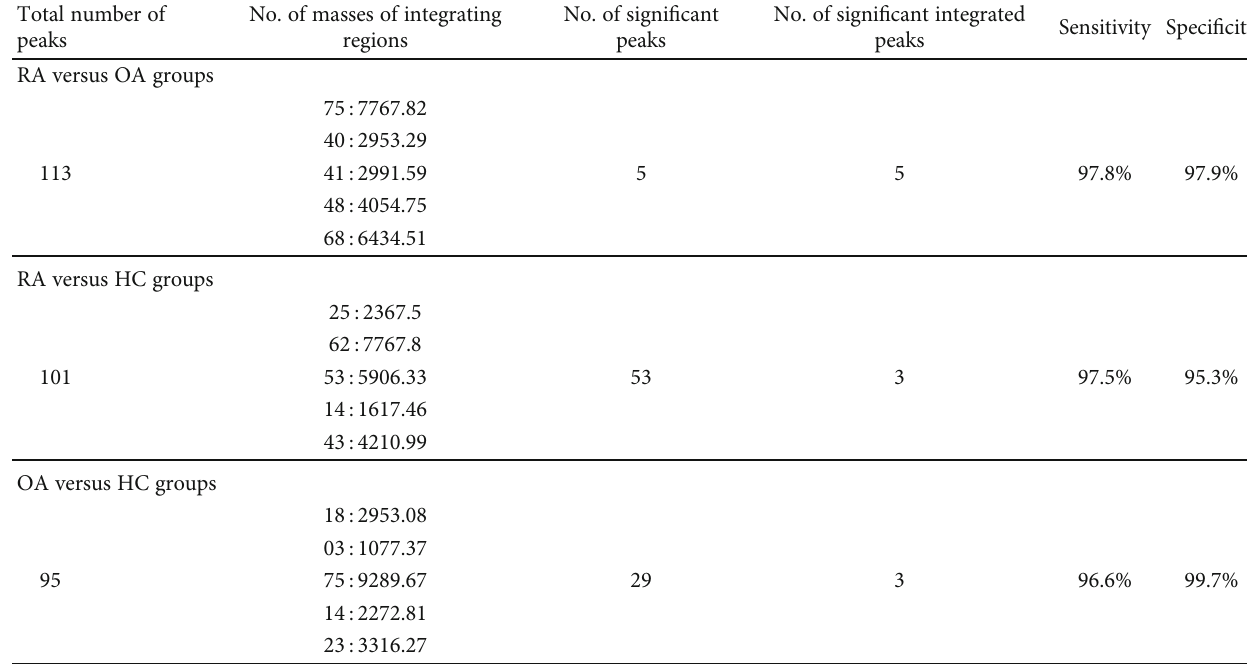
Table 3: Serum peptidomic pro fi le of the three training